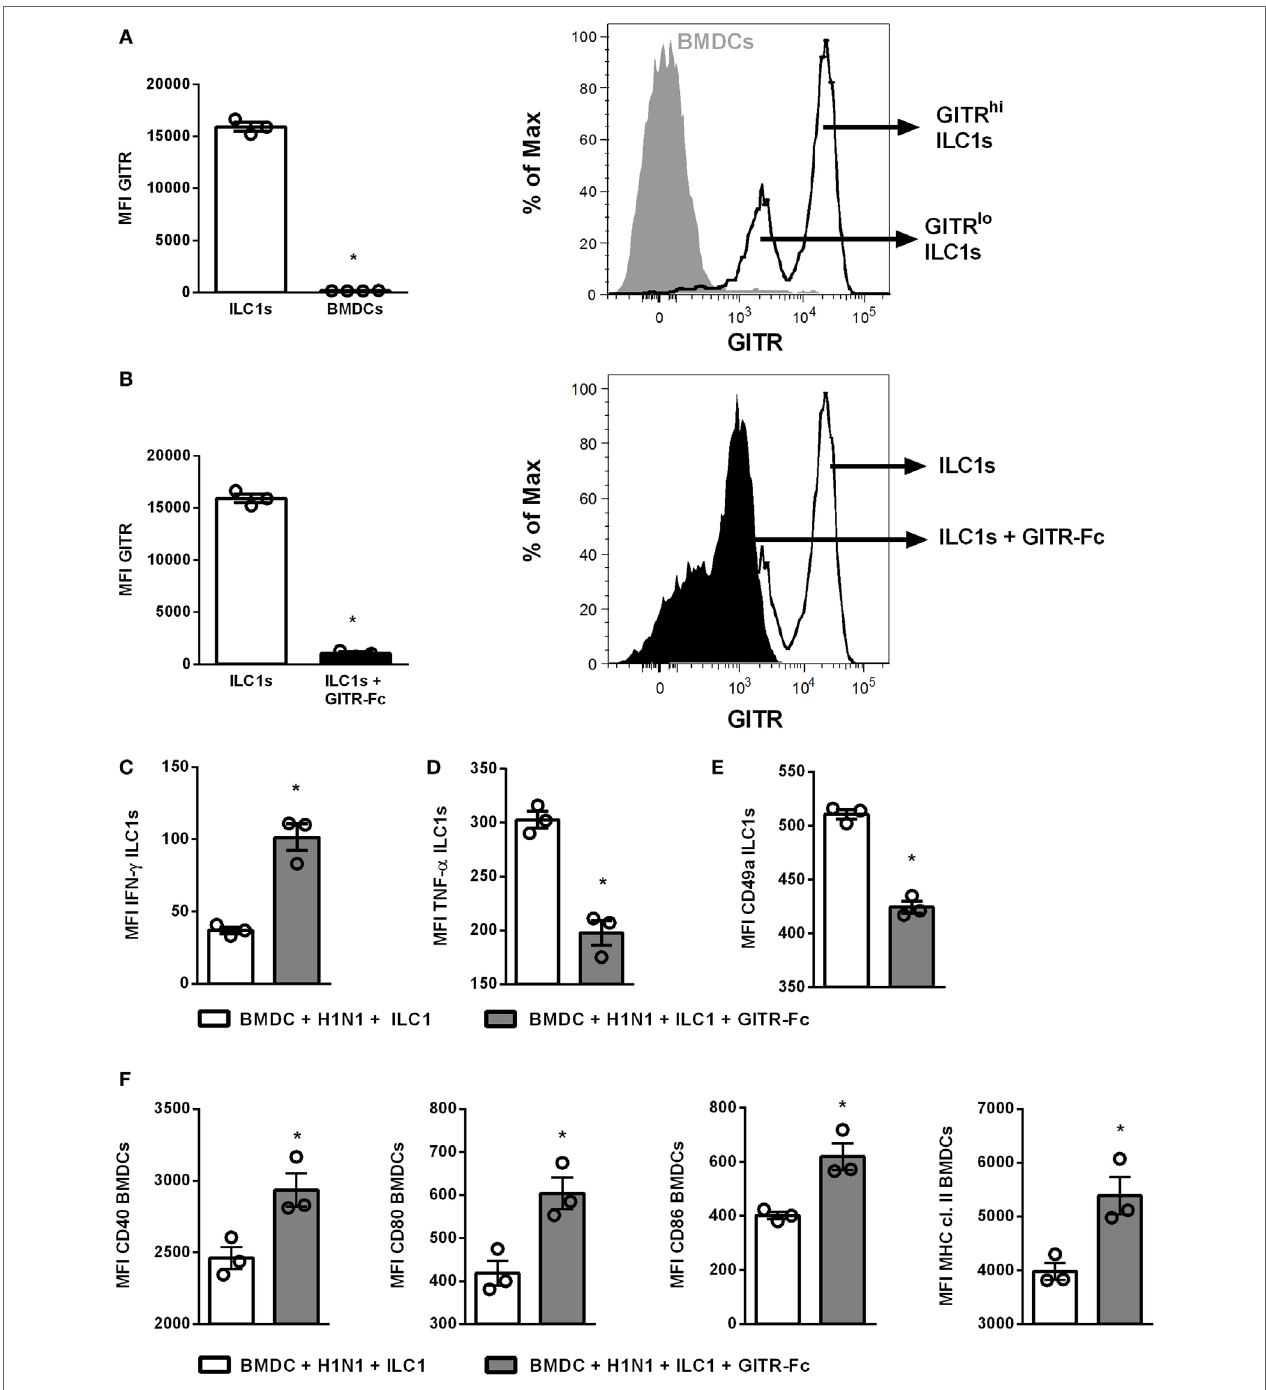
FigUre 5 | GITR-expression modulates ILC1 functionality upon coculture with H1N1-infected BMDCs. BMDCs generated from wild-type mice using FLT-3 ligand stimulation were infected with the H1N1 PR8 strain (at a MOI of 1). In vitro -generated ILC1s were cocultured overnight with infected or uninfected BMDCs at a 1:1 ratio. The recombinant mouse GITR-Fc chimera protein was applied to the coculture overnight to manipulate GITR expression. Surface and cytokine staining were performed for flow cytometry analysis after 3 h of incubation in media with brefeldin and monensin. (a) GITR expression by ILC1s and BMDCs represented as MFI and representative histogram. (B) MFI of GITR expression by ILC1s with and without GITR-Fc treatment and representative histogram. MFI of (c) IFN- γ , (D) TNF- α , and (e) CD49a expression after GITR-Fc treated ILC1s cocultured with H1N1-infected BMDCs. (F) MFI of CD40, CD80, CD86, and MHC cl. II expression by infected BMDCs post-GITR-Fc treatment. Bars with scatter plots represent the mean ± SEM ( n = 3–4) and MFI data are representative from one out of two independent experiments. Asterisks denote significant values as calculated by nonparametric Mann–Whitney’s test; **** p ≤ 0.0001; *** p ≤ 0.001; ** p ≤ 0.01; * p ≤